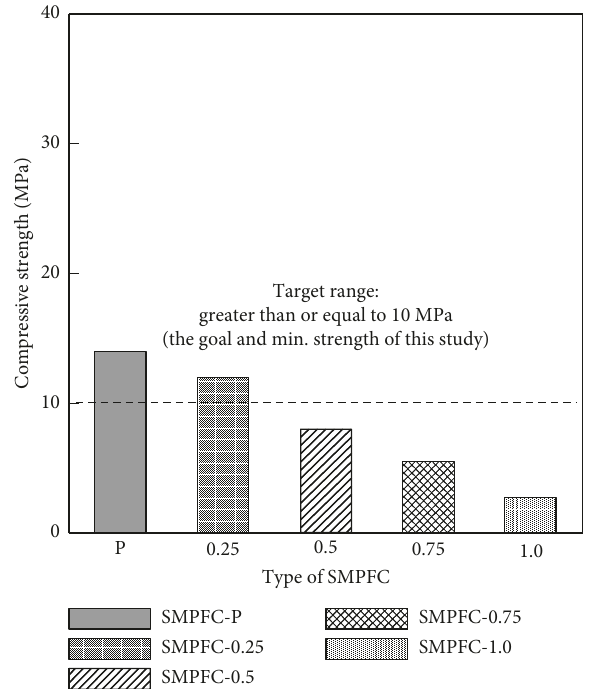
Figure 6: Test results of compressive strength (7D).